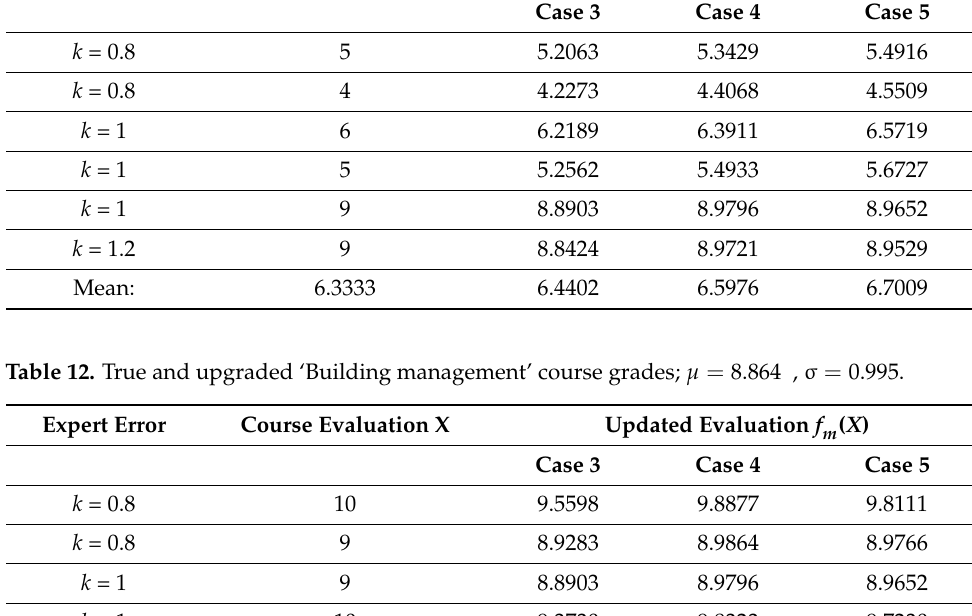
Table 11. ‘ Structural engineering’ course evaluations; µ = 8.864 , σ = 0.995. Expert Error